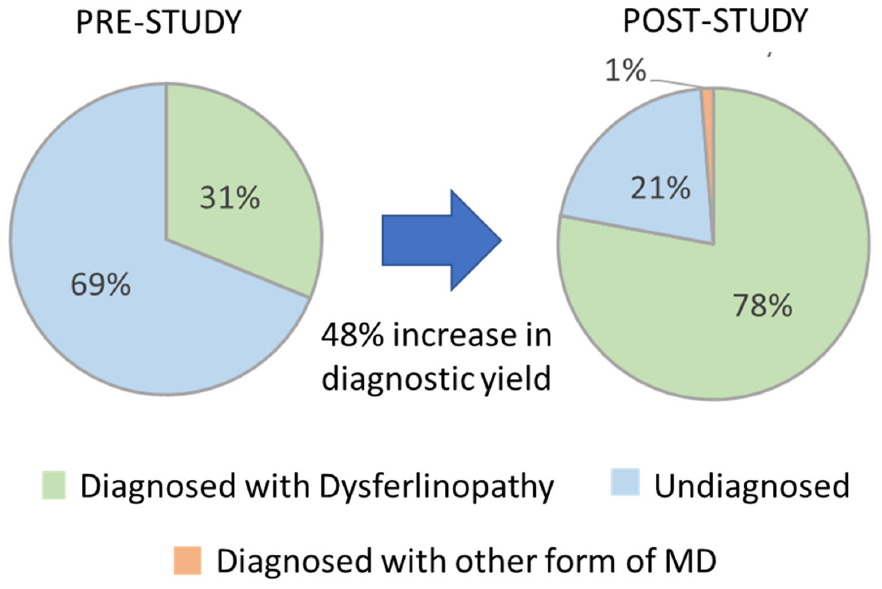
Figure 4. Increase in diagnostic yield.